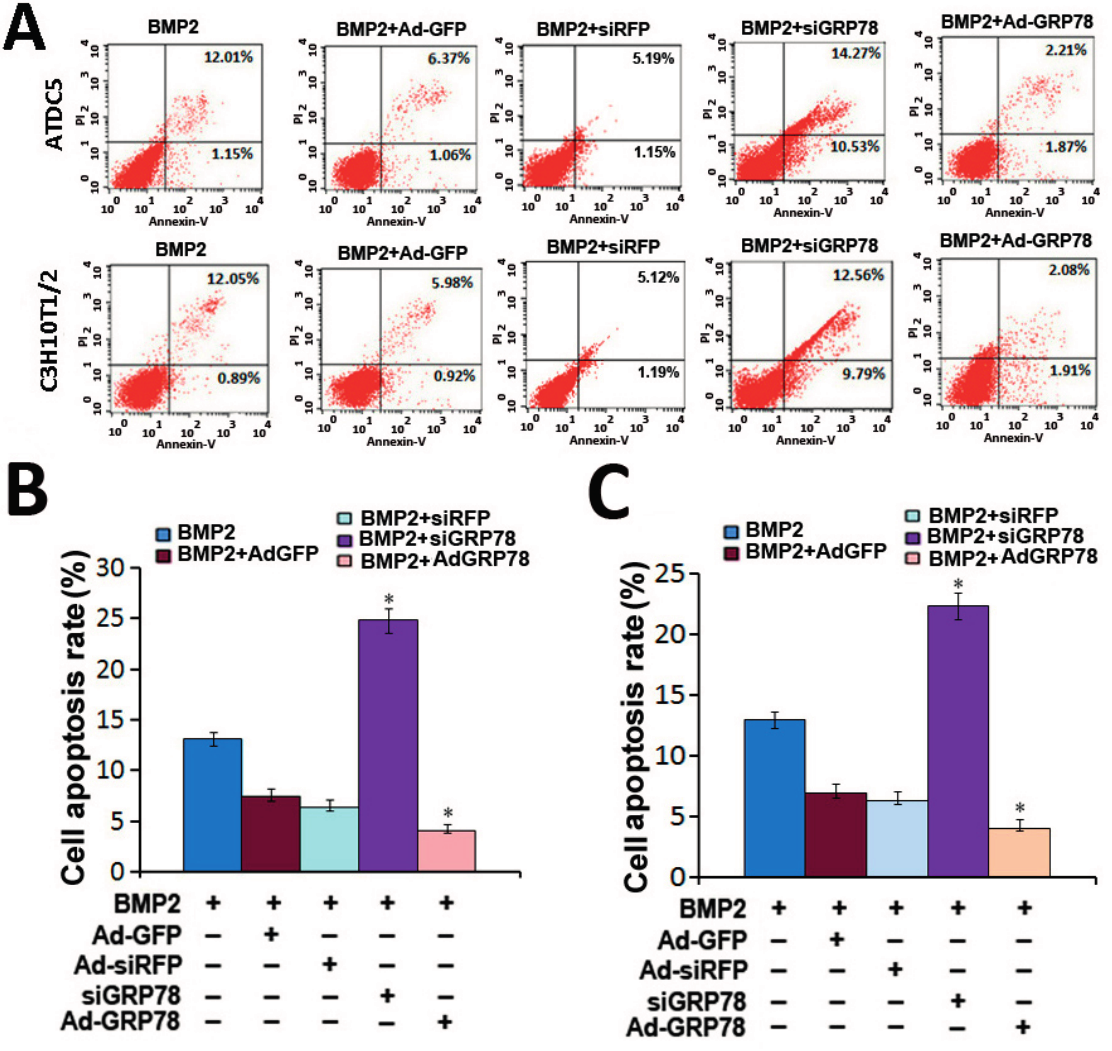
Figure 5. Cellular apoptosis assay with FCM. ( A ) Flow cytometry analysis with Annexin V-PI staining was performed to evaluate the percentage of apoptotic cells in